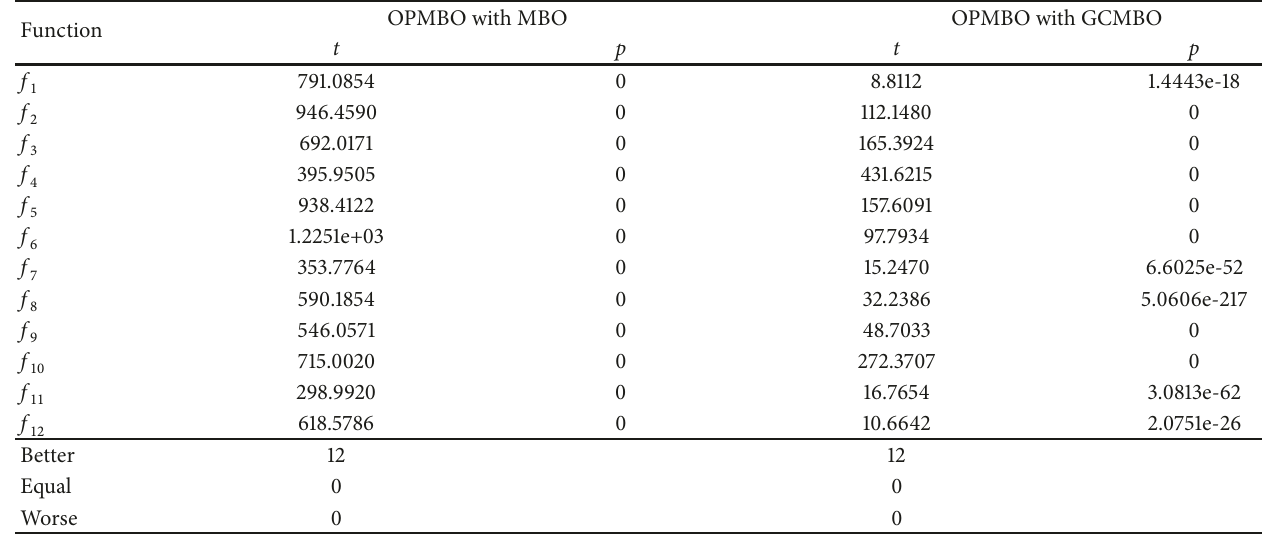
Table 6: The two-tailed t-test of the experimental results on 100-dimensional benchmark functions. Function